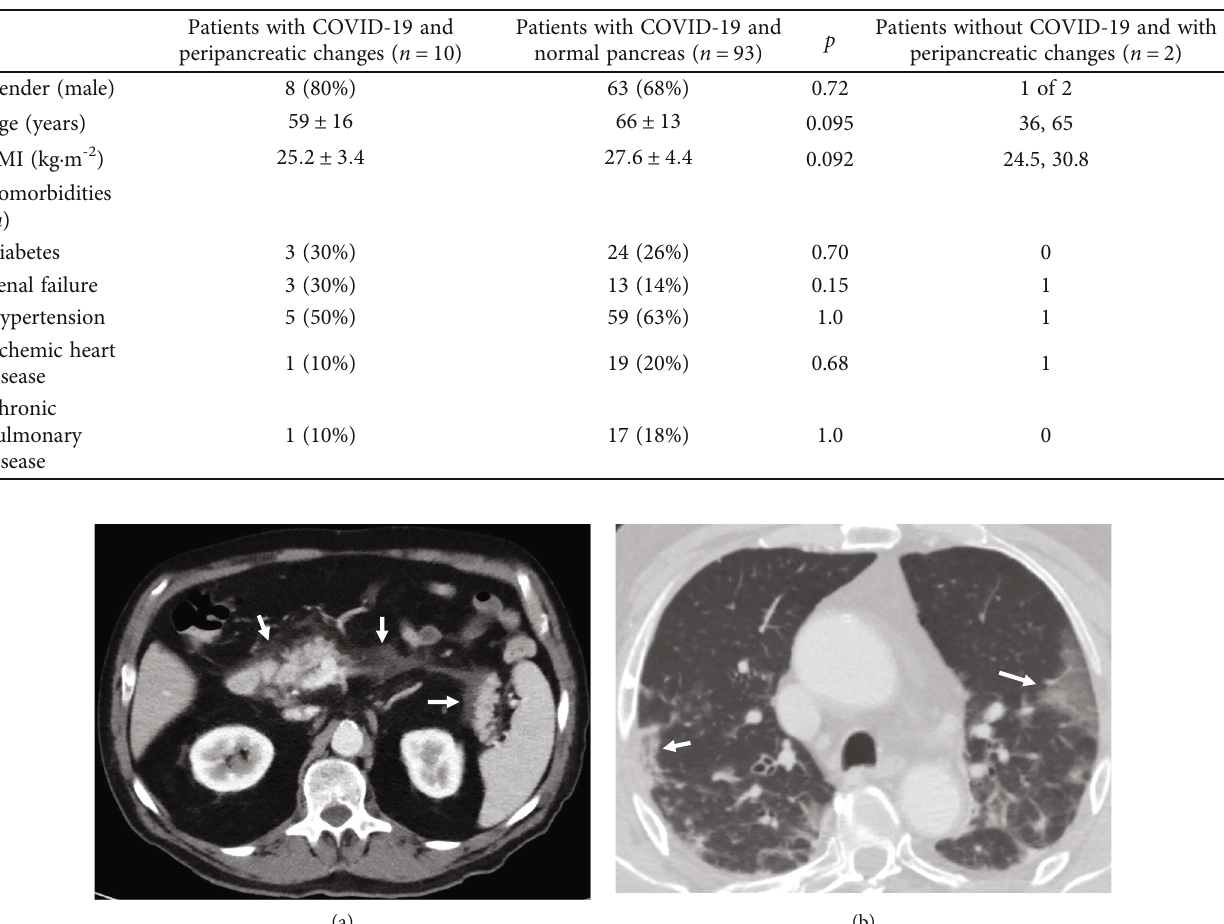
Table 1: Demographic data of patients.